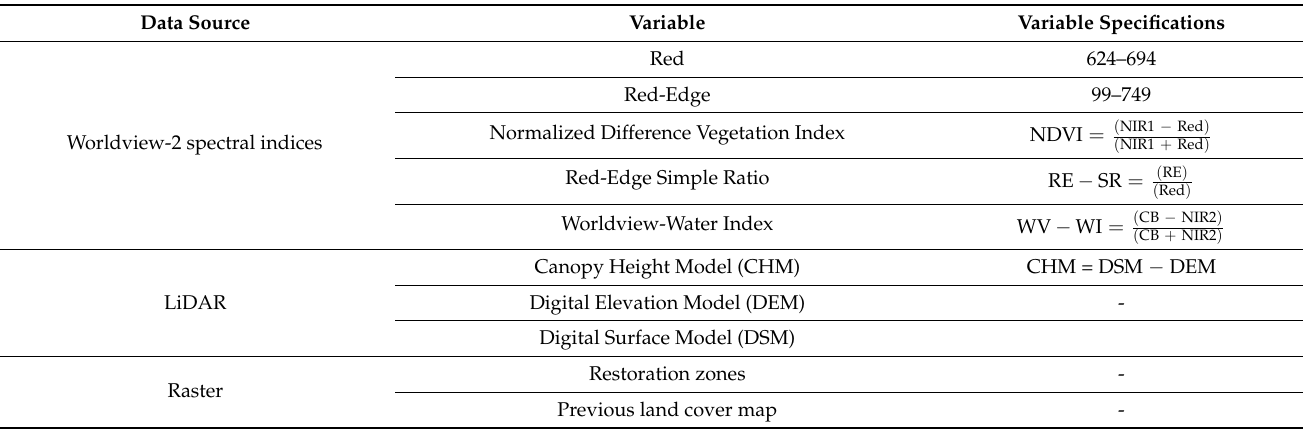
Table 3. Summary of the image layers used to classify the nine land cover classes at Yandina Creek